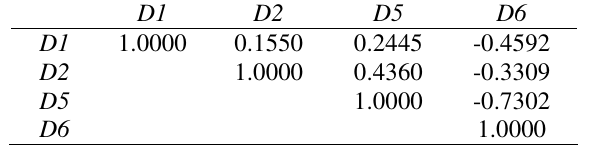
(1-20) (µM) 2 and estimated IC 50